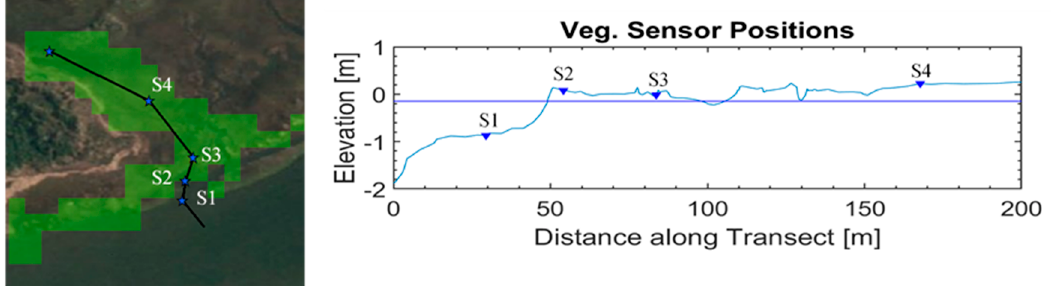
Figure 2. The position of the sensors horizontally and vertically across the marsh. The elevations are measured relative to the mean sea level (MSL) which is indicated by the blue line of the vertical